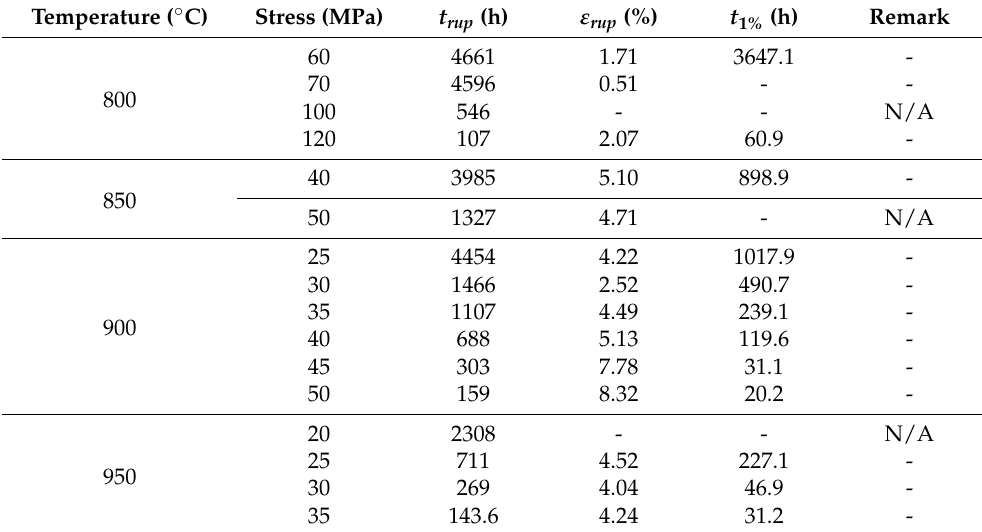
Table 2. The stress-rupture test data showing t rup , ε rup , and t 1 % . Temperature ( ◦ C) Stress